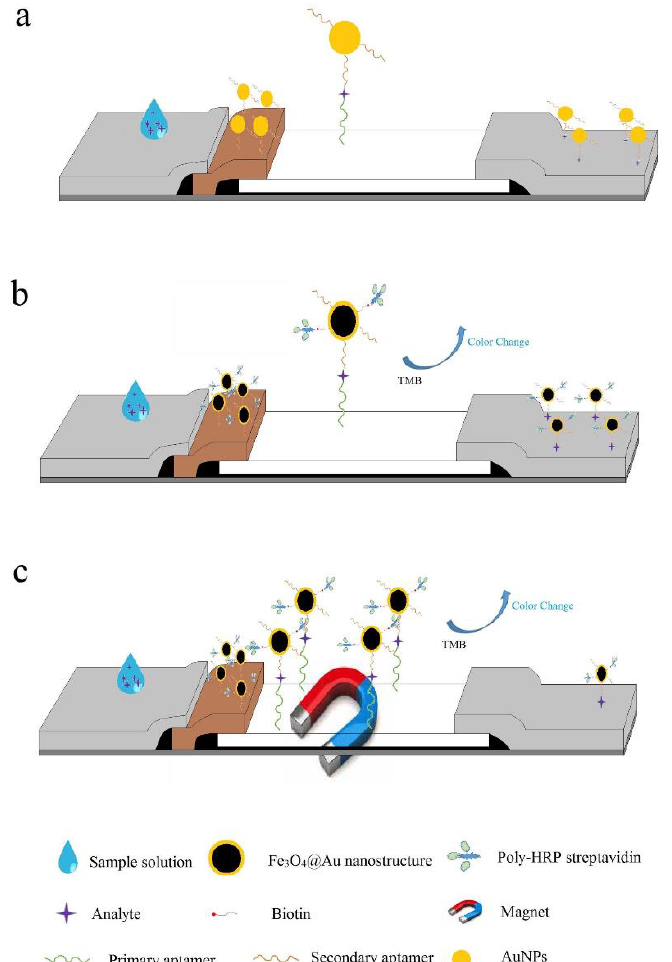
Figure 6. Schematic illustration of the principles of the traditional AuNPs-based lateral flow immunochromatographic assay method ( a ) the enzyme signal amplification-based based lateral flow immunechromatographic method ( b ) and the Fe 3 O 4 @Au NPs based lateral flow immunechromatographic method assisted with enzyme amplification and external magnetic field ( c ). Reprinted from [95] with permission from Elsevier, 2020.